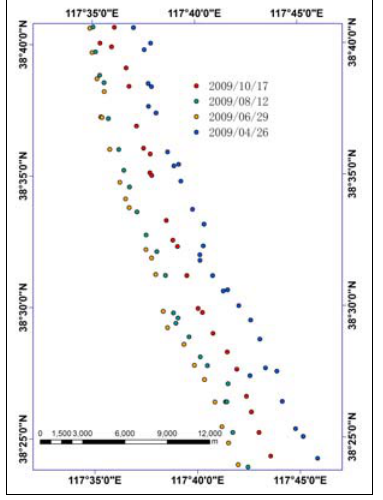
Figure.7 the optimal discrete waterline points